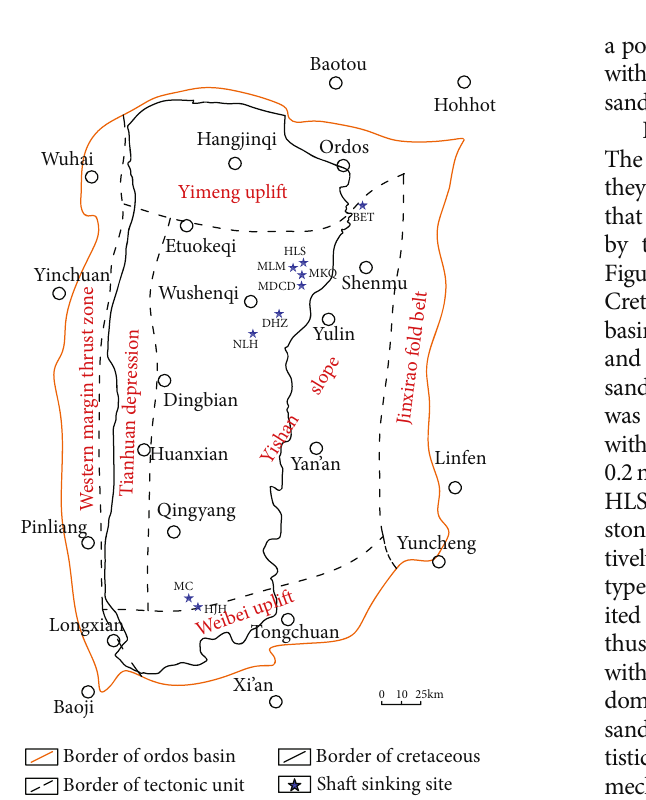
Figure 3: Shaft sinking sites in Ordos basin after Hou et al.